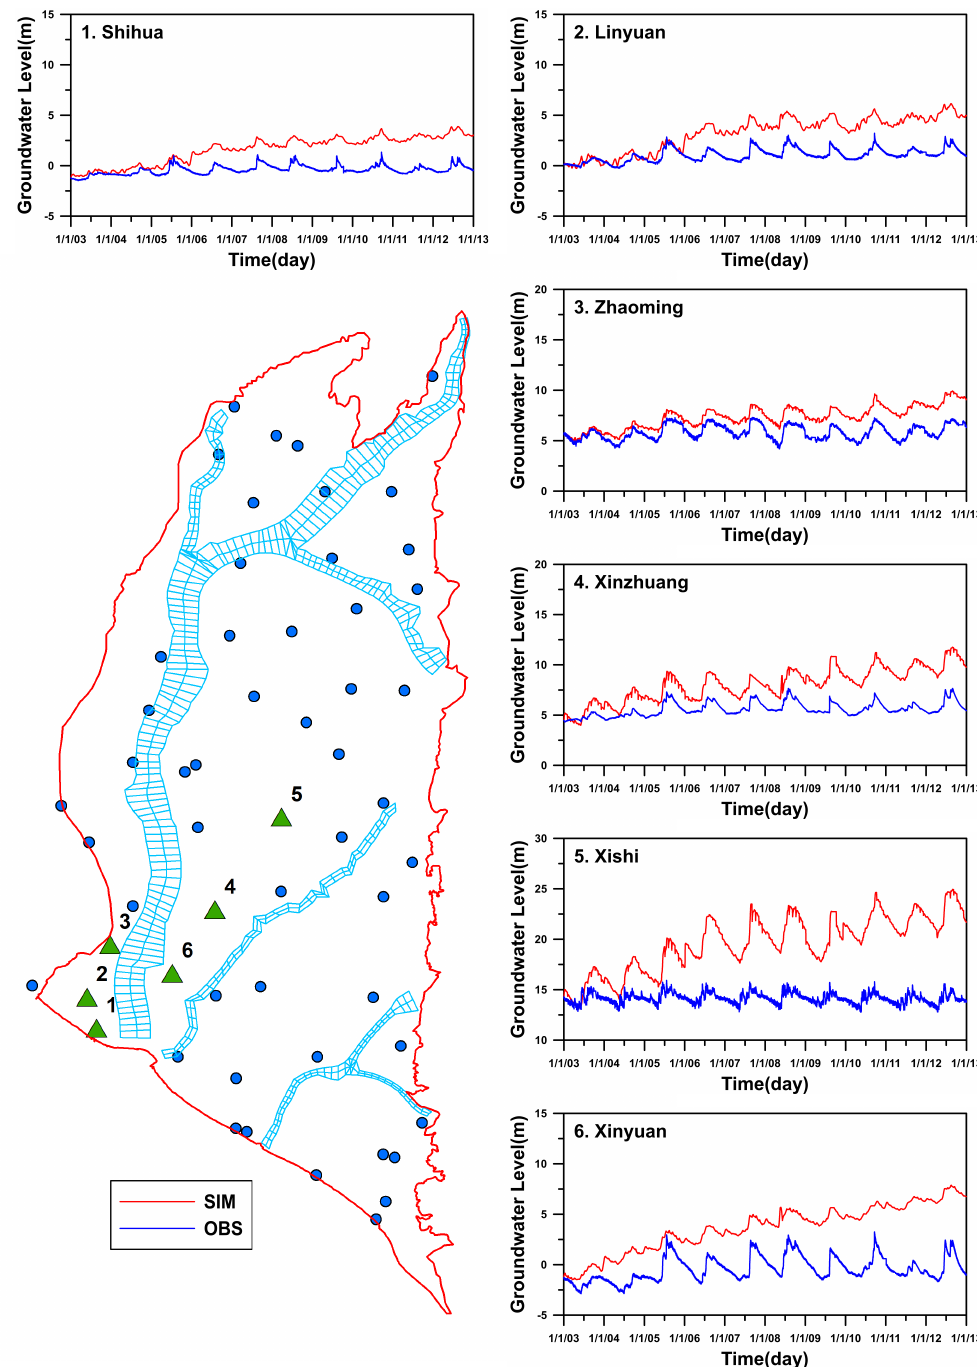
Figure 10. Comparisons between simulated and observed groundwater level series at selected sites along the downstream of the Gaoping River from